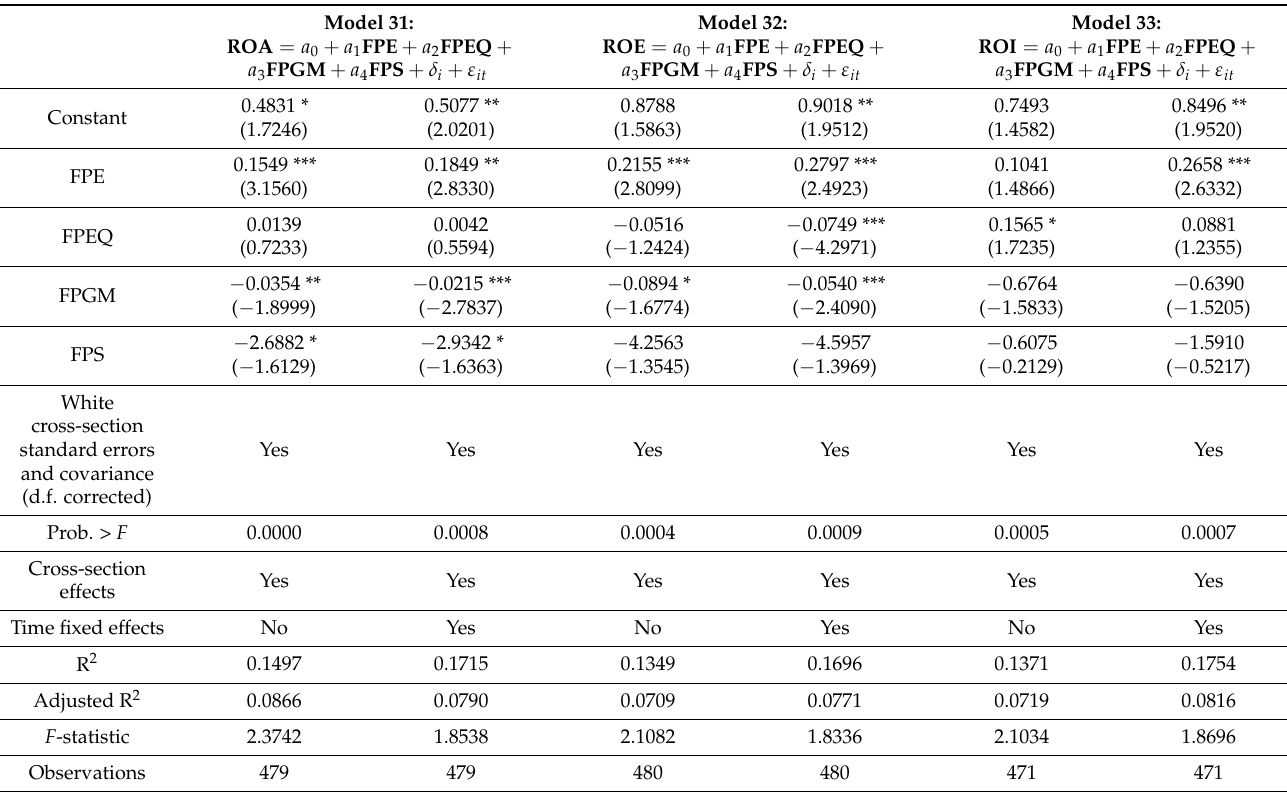
Table 13. Econometric models for electricity